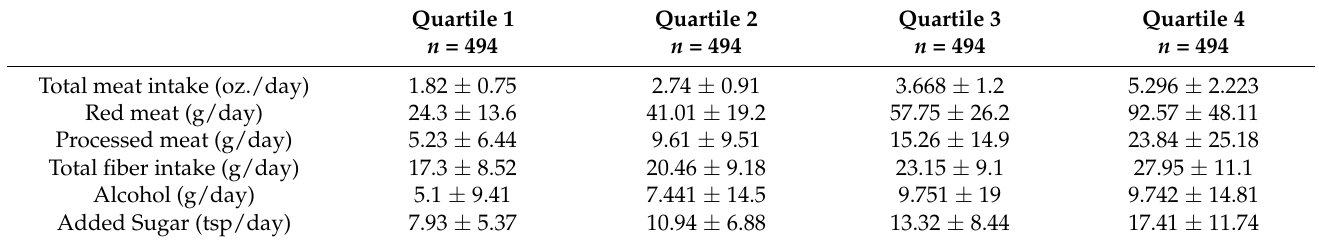
polyps previous to qualifying for colonoscopy; c Regular aspirin use (in the last 4 weeks prior to enrollment).